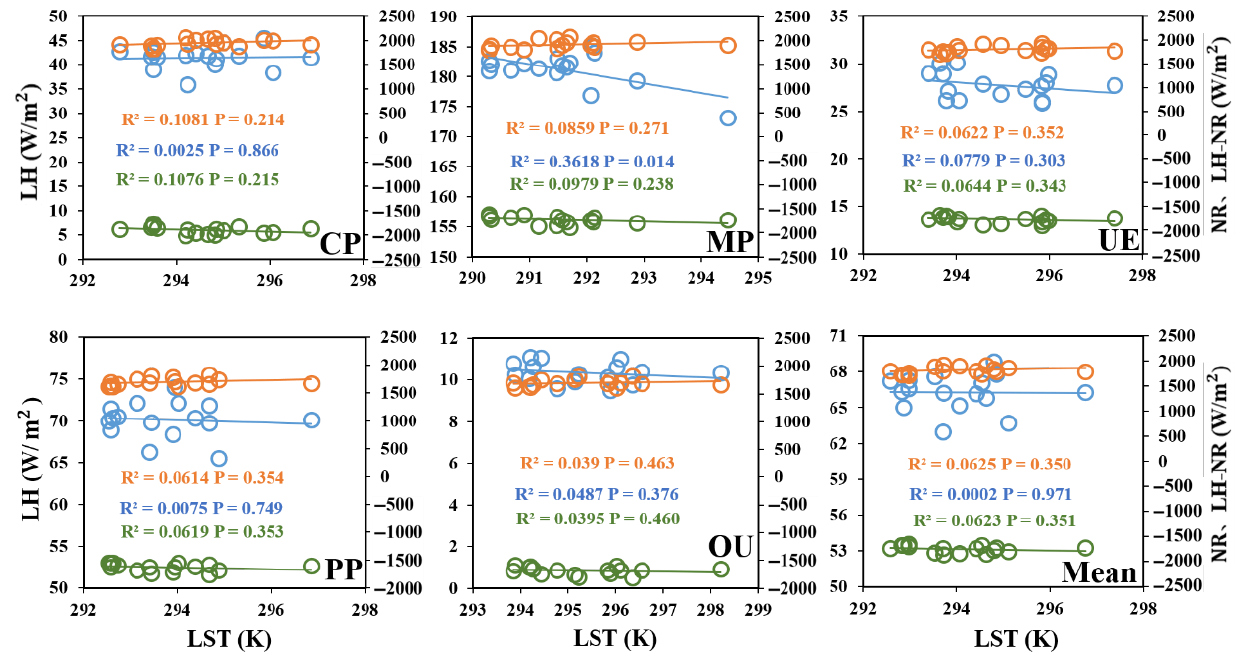
Figure 18. Correlation between LST, NR and LH–NR in the Huang-Huai-Hai River Basin from 2000 to 2015 (blue dots and blue lines represent LST and NR scatter plots, red dots and red lines represent LST and LH scatter plots, and green dots and green lines represent LST and LH–NR scatter plots).